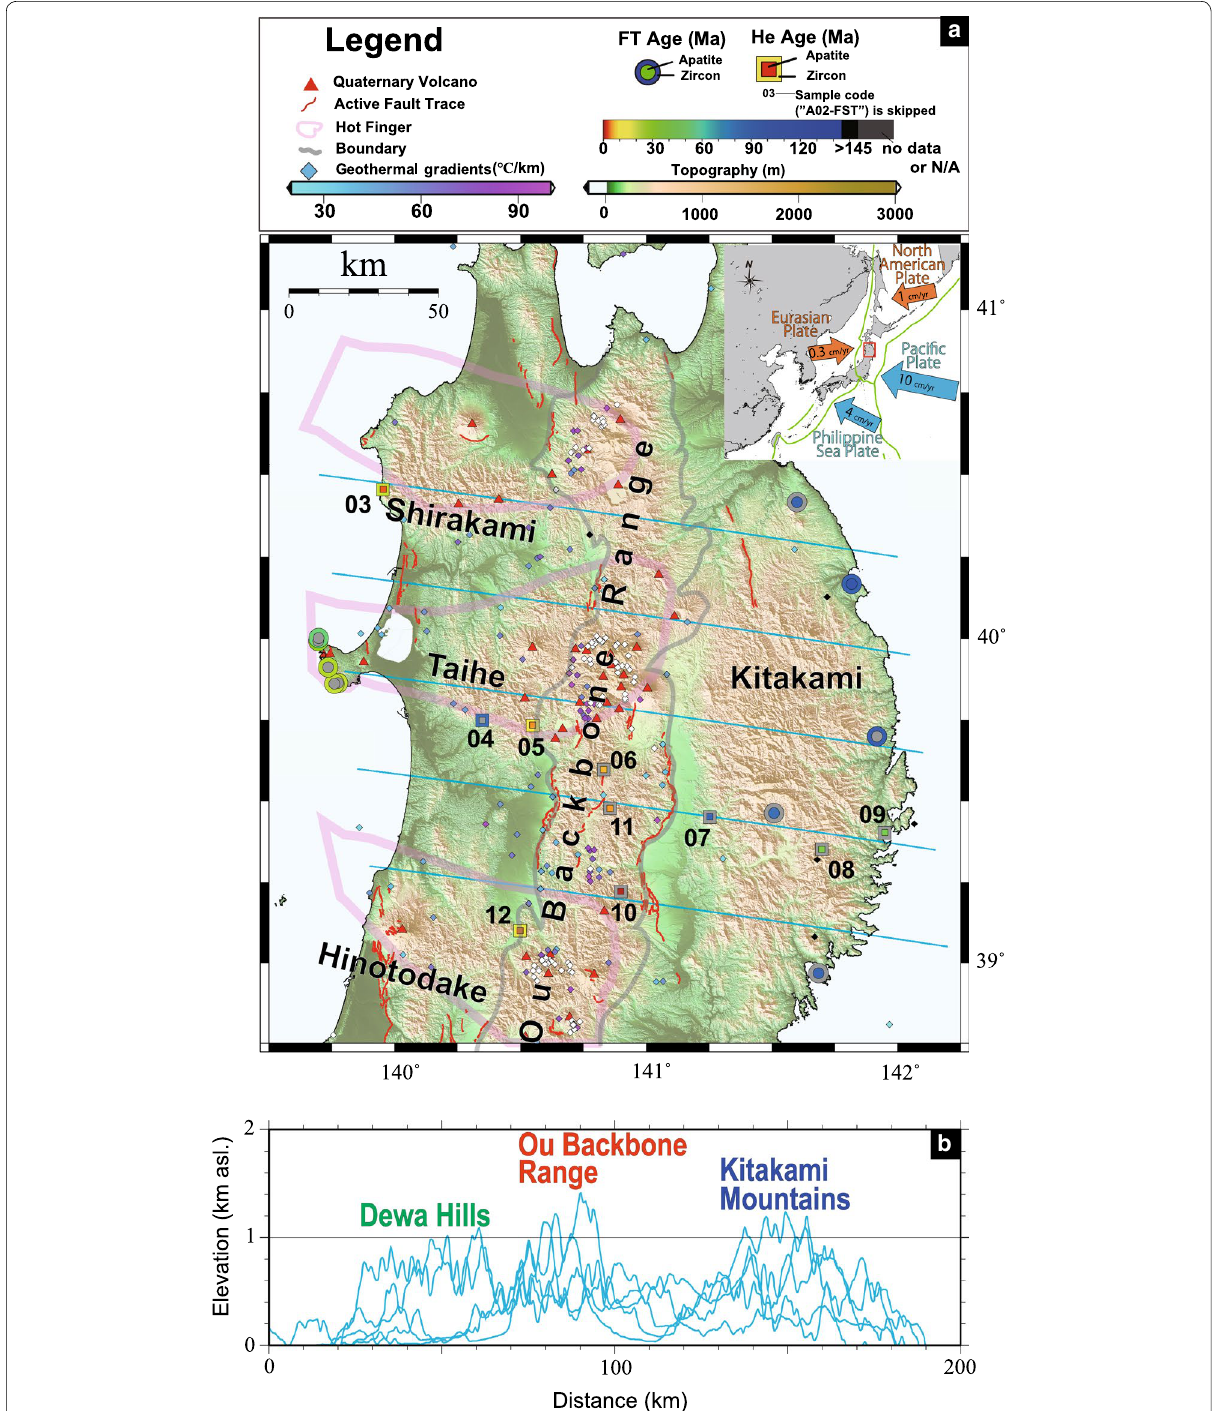
Fig. 1 a Index map of the study area of the N-traverse. Numbered localities are our sampling sites. (U–Th)/He ages obtained in this study are also shown. Quaternary volcanoes: Committee for Catalog of Quaternary Volcanoes in Japan (1999); Active fault traces: Nakata and Imaizumi (2002); Hot Fingers: Tamura et al. (2002); Geothermal gradients: Tanaka et al. (2004); FT age: ages without sample codes indicating data from previous studies: Ganzawa (1987) on the back-arc side, and Goto (2001) on the fore-arc side; Boundaries: the lines showing the eastern and western limits of the OBR, defined by Koike et al. (2005). b Geomorphic cross section of study area. The cross sections were drawn along the 5 light blue lines in Figure ( a ). These figures were drawn using Generic Mapping Tools (GMT; Wessel and Smith 1991) and 50-m mesh digital elevation model (DEM) of the Geospatial Information Authority of Japan